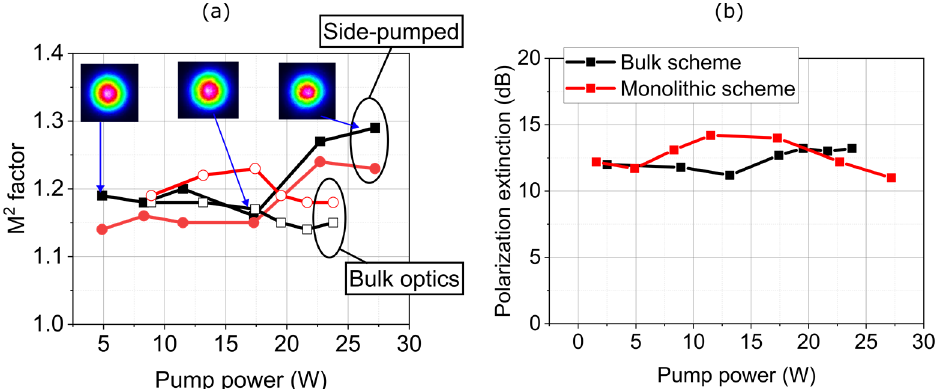
Figure 7. ( a ) The M 2 factor dependence on the pump power. The red curves are for “X” axis and the black curves are for “Y” axis of the M 2 factor. ( b ) The polarization extinction ratio evolution in both schemes.